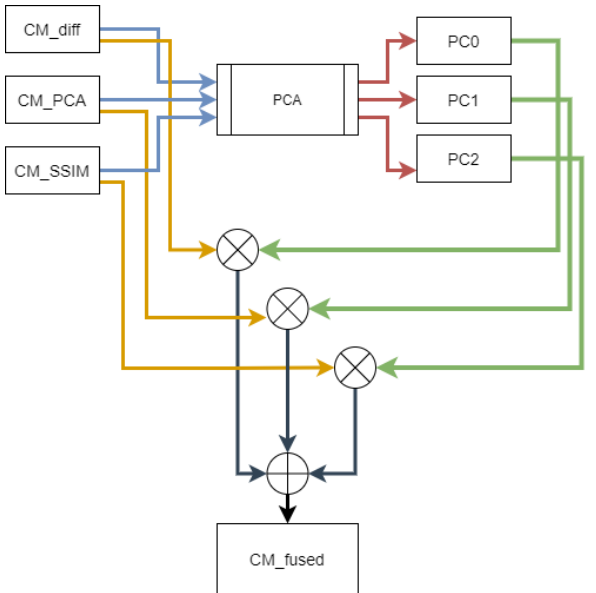
Figure 11. Diagram of change map fusion by PCA.